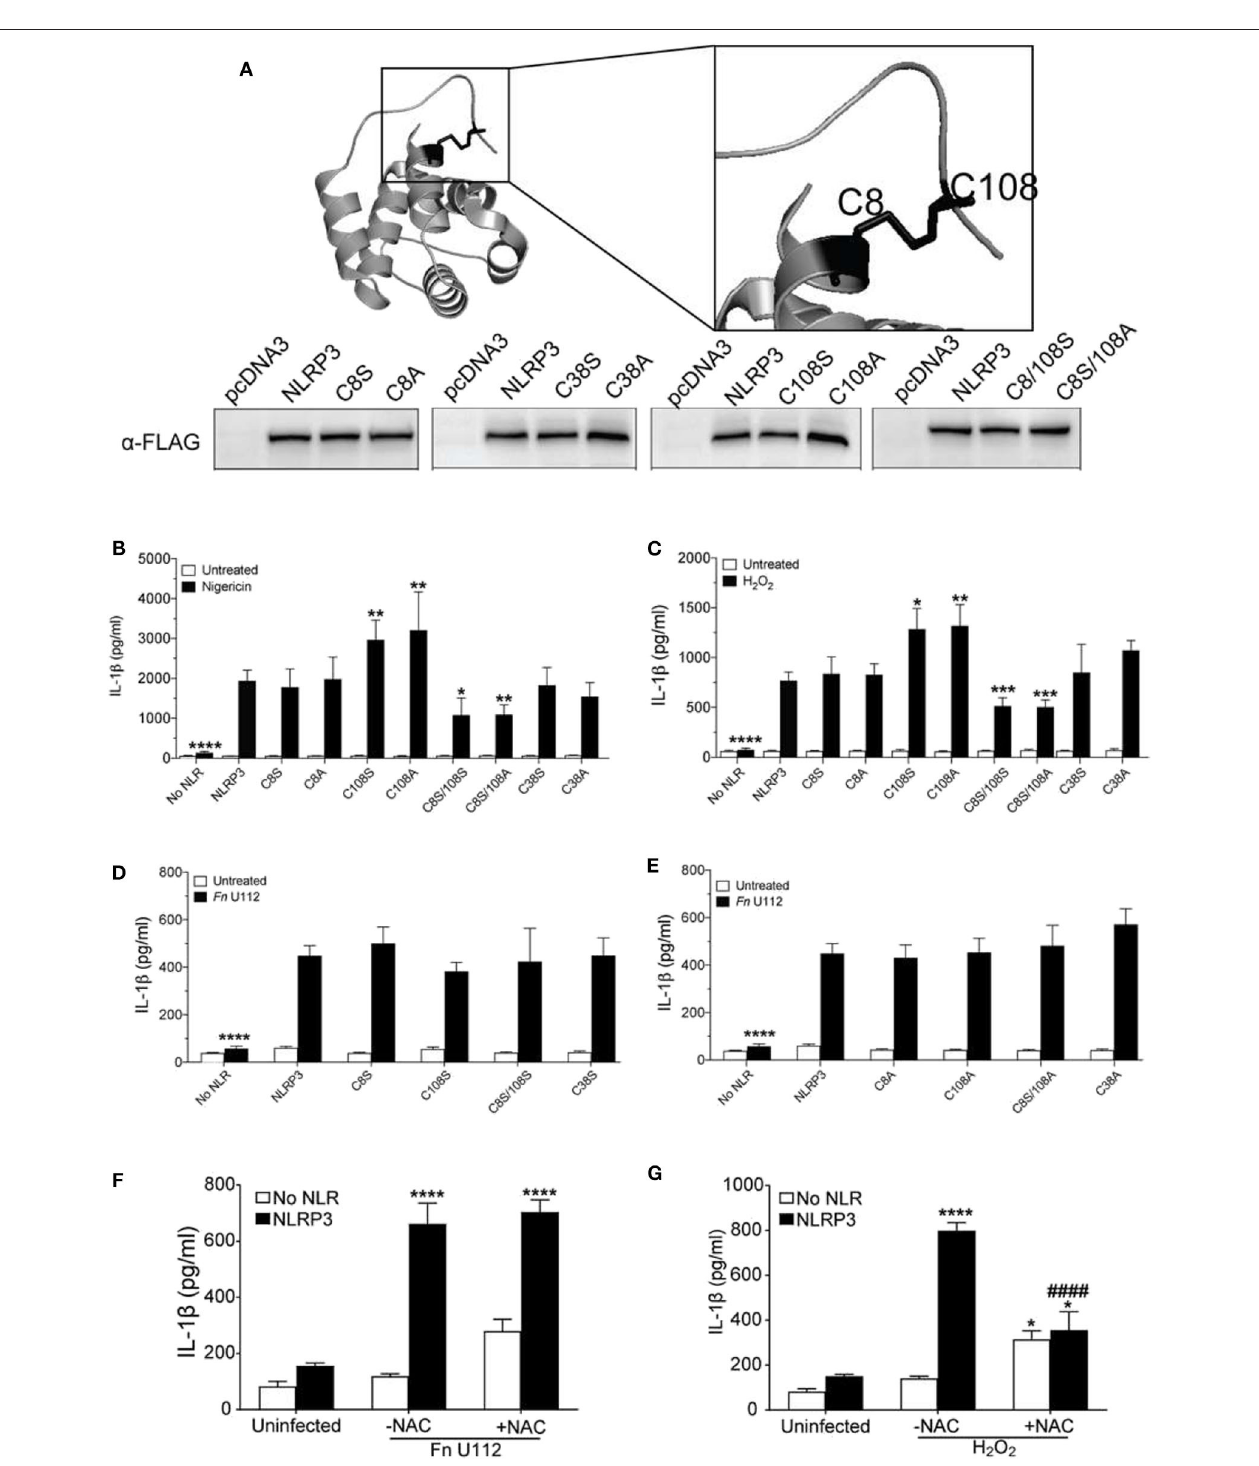
FIGURE 4 | The NLRP3 response to sterile agonists requires conserved N-terminal cysteines. (A) Crystal structure of NLRP3-PYD (PDB ID:3QF2) generated with PyMOL showing positions of C8, C38, and C108 (top), Western blot of FLAG-tagged NLRP3 and its cysteines mutants from HEK293T cell lysate. 20 µ g total protein was loaded (bottom). (B,C) IL-1 β response of HEK293T cells expressing ASC, pro-Caspase-1, pro-IL-1 β , and NLRP3, or C → S/A mutants. (B) At 18–20h post-transfection, cells were treated 5 µ M nigericin (2h) or (C) with 100 µ M H 2 O 2 (1h). (D,E) IL-1 β response of HEK293T cells expressing ASC, pro-Caspase-1, pro-IL-1 β , and NLRP3 or (D) C → S mutants or (E) C → A mutants. At 4-h post-transfection, cells were infected with Fn U112 (MOI 100) and IL-1 β in culture